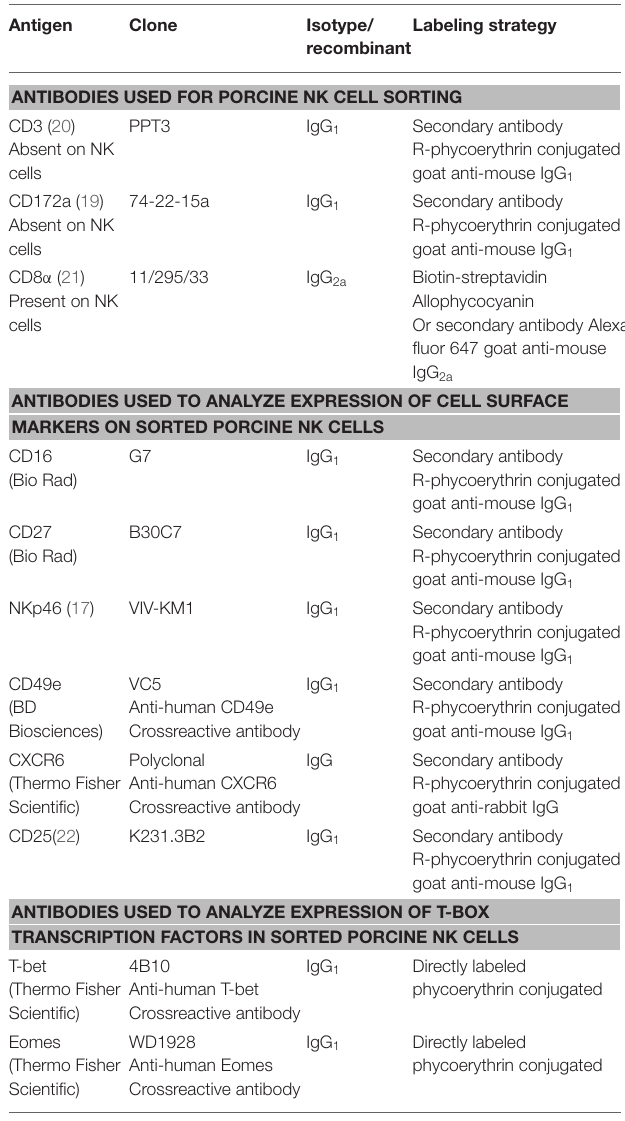
TABLE 1 | Primary and secondary antibodies used for cell surface expression and transcription factor analysis by flow